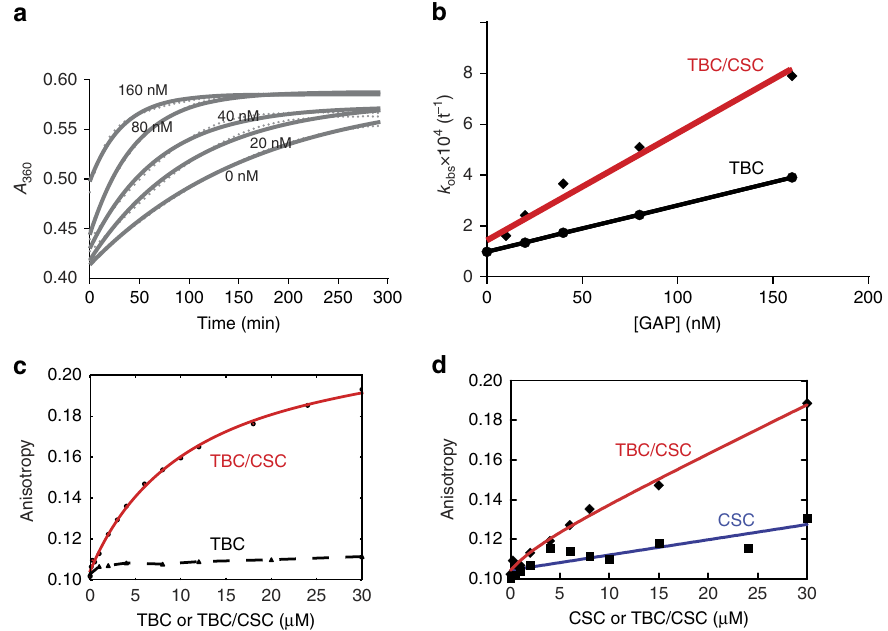
Figure 4 | CSC promotes the GAP activity of TBC1d5 and its interaction with Rab7. ( a ) Kinetics of GTP hydrolysis for Rab7 in the absence and presence of the indicated concentrations of TBC1d5 TBC . The absorbance at 360nm reports the amount of a conjugate of GTP hydrolysis product, Pi. Solid lines represent a fit of experiment data to the pseudo-first-order Michaelis–Menten equation. ( b ) Calculated k obs for TBC1d5 TBC or TBC1d5 TBC /CSC as a function of of Rab7 concentration. Solid lines represent a linear fit between k obs and Rab7 concentration, giving rise to catalytic efficiency ( k cat / K m , slope) and intrinsic rate constant ( y intercept). ( c ) Fluorescence anisotropy direct binding assay, in which TBC1d5 TBC or TBC1d5 TBC /CSC was added to Alexa Fluor 488-labelled Rab7-GMPPNP. Solid lines represent a fit with changes in fluorescence anisotropy. ( d ) Fluorescence anisotropy direct binding assay, in which CSC or TBC1d5 TBC /CSC was added to Alexa Fluor 488-labelled